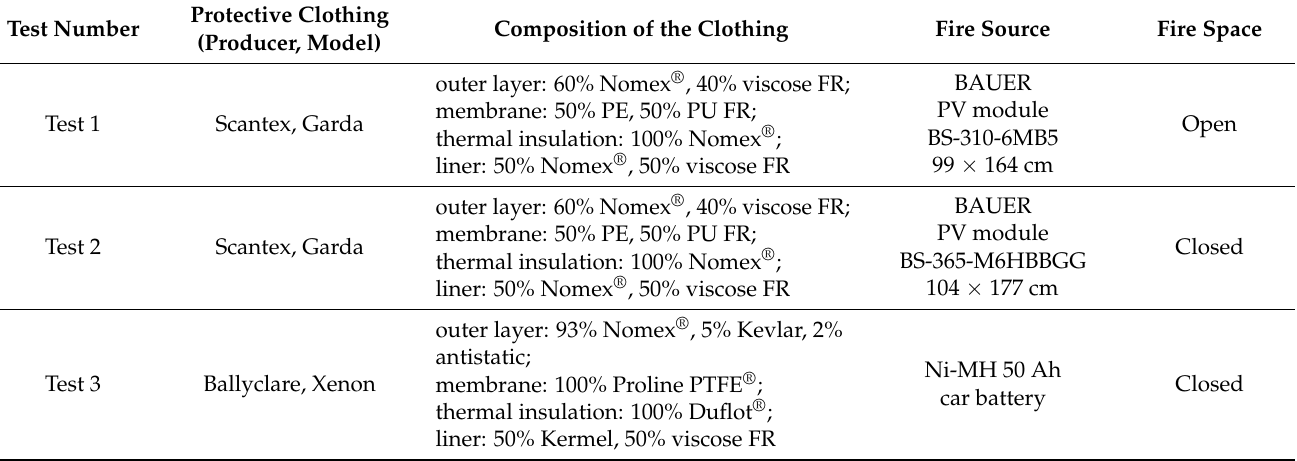
Table 3. The experimental testing conditions.